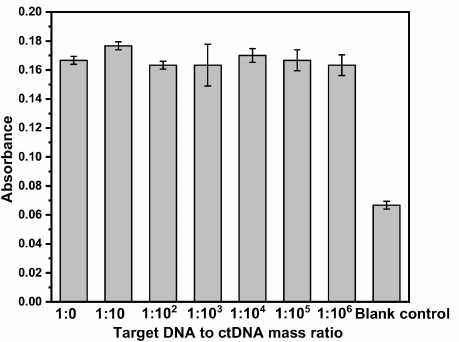
Figure 4. The absorbance signal of 1 pM target DNA in the presence of increasing amounts of